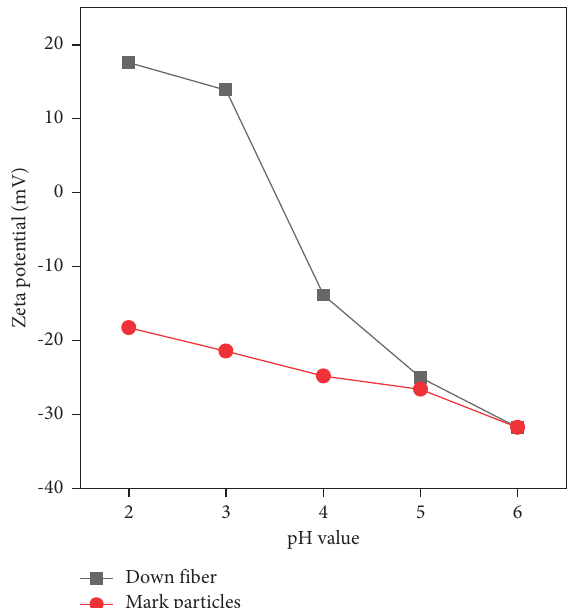
Figure 5: Zeta potential of down fiber and mark particles.